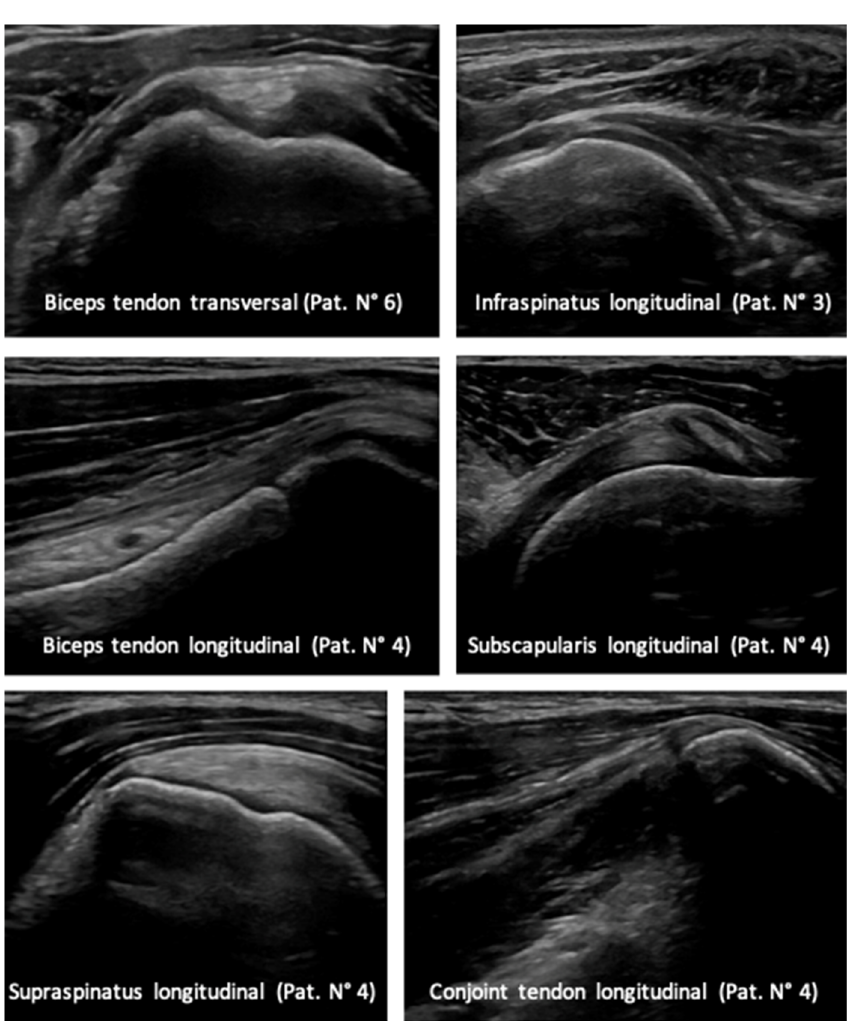
Figure 4. Sonographic scans 2 years postoperatively of the soft tissue surrounding the shoulder joint.